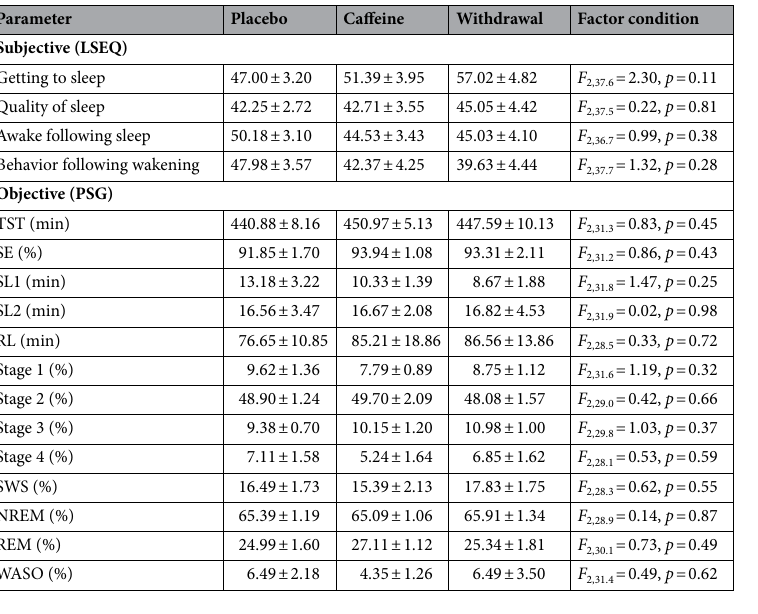
Table 1. Subjective and objective sleep parameters per condition and results of the analyses. LSEQ Leeds Sleep Evaluation Questionnaire; PSG polysomnography . Values represent means ± standard errors for each variable and condition. Lower values in the four scales of the subjective ratings indicate worse sleep quality. TST total sleep time (stages 1–4 + REM sleep); SE sleep efficiency (TST/time in bed × 100); SL1: sleep latency to stage 1, i.e. time from lights off to first occurrence of stage 1; SL2: sleep latency to stage 2, i.e. time from lights off to first occurrence of stage 2; RL REM sleep latency, i.e. time from sleep onset to first occurrence of